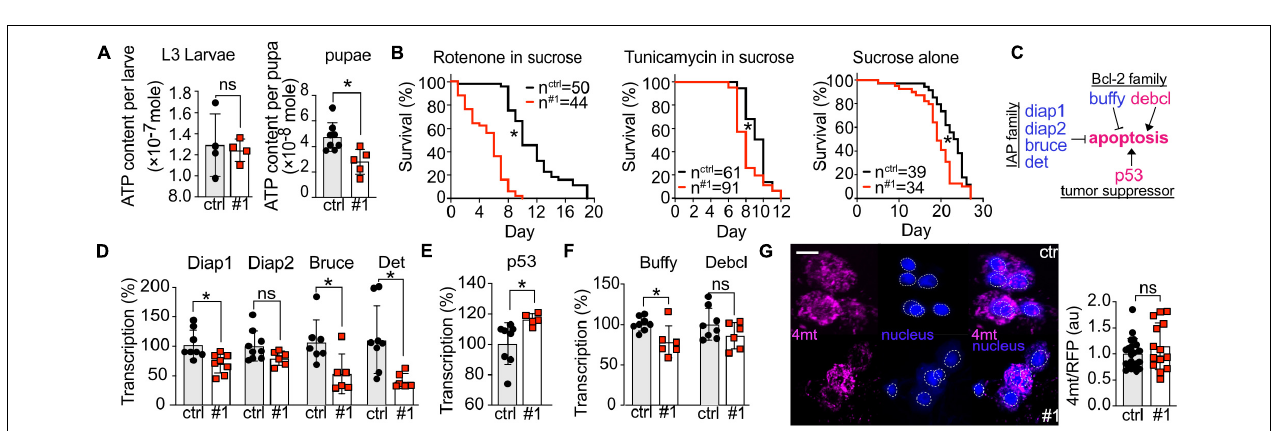
FIGURE 5 | Knockdown of dTmbim5 results in reduced ATP levels and a pro-apoptotic dysregulation of genes involved in apoptosis. (A) ATP levels per larva or pupa of tubP > > dTmbim5-RNAi flies. (B) Lifespan on food containing rotenone (10 µ M in 5% sucrose), tunicamycin (10 µ M in 5% sucrose), or sucrose (5%) alone. (C) Genes that regulate apoptosis in flies. Blue: anti-apoptotic. Magenta: pro-apoptotic. (D–F) Abundance of genes involved in apoptosis quantified by qPCR in the heads of elav > > dTmbim5-RNAi #1 flies. (D) Inhibitor of apoptosis (IAP) proteins, (E) p53A, and (F) Bcl-2 family members. (G) Relative mitochondrial calcium levels in Pdf neurons quantitated by 4mtGCaMP3 (4mt) fluorescence normalized to RFP expressed in Pdf > > dTmbim5-RNAi #1 flies. The 4mt signal was normalized to the mean of the control group as well as the RFP signal in the same neuron. Ctrl, UAS-Always-early-RNAi control group. Scale bar in (G) 1 µ m. Bars in (A,D,E,F,G) represent the mean ± SD and each dot corresponds to a group of two animals in (A) , 10 heads in (D–F) , and one brain in (G) . Statistical significance was calculated using the independent t test in (A,D,E,F,G) and the log-rank test and Gehan–Breslow–Wilcoxon test in (B) . ns, not significant. * p < 0.05. Dotted circles represent the regions of